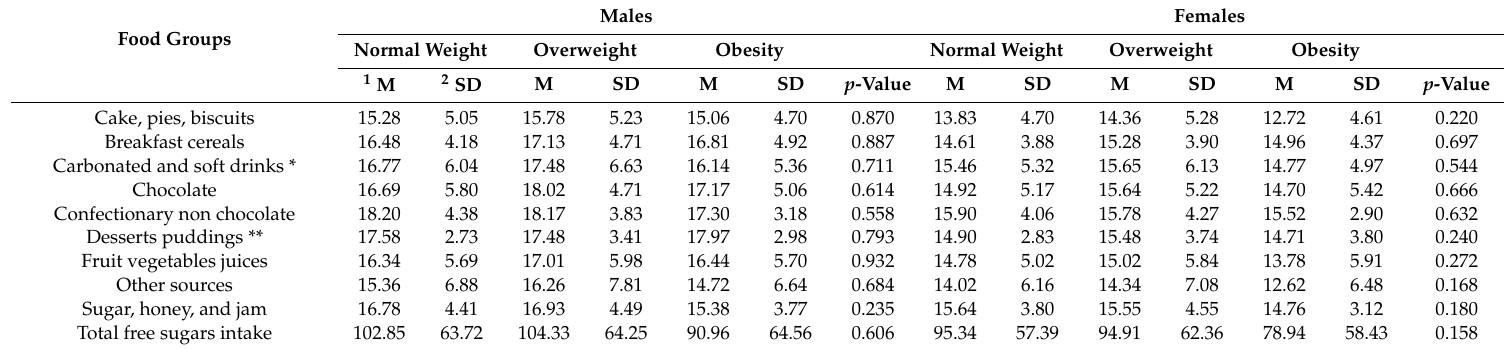
Table 2. Free sugars mean intake from the main contributing food groups by body mass index categories between gender for all participants (ANCOVA). Males Females Food Groups Normal Weight Overweight Obesity Normal Weight Overweight Obesity 1 M 2 SD M SD Cake, pies, biscuits